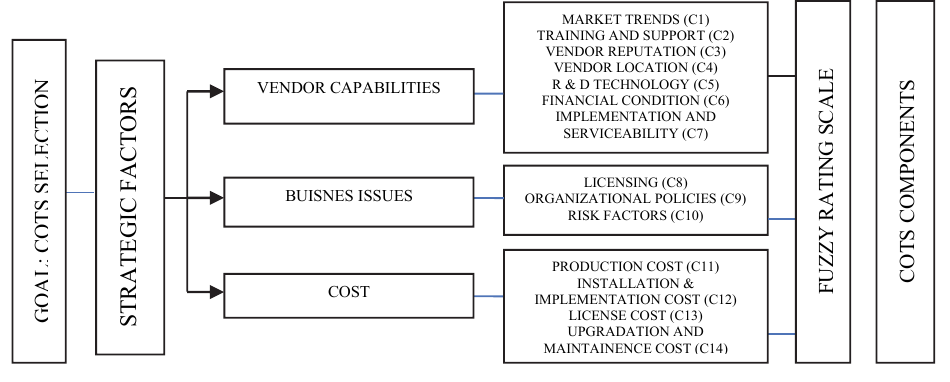
Fig. 3. COTS ranking